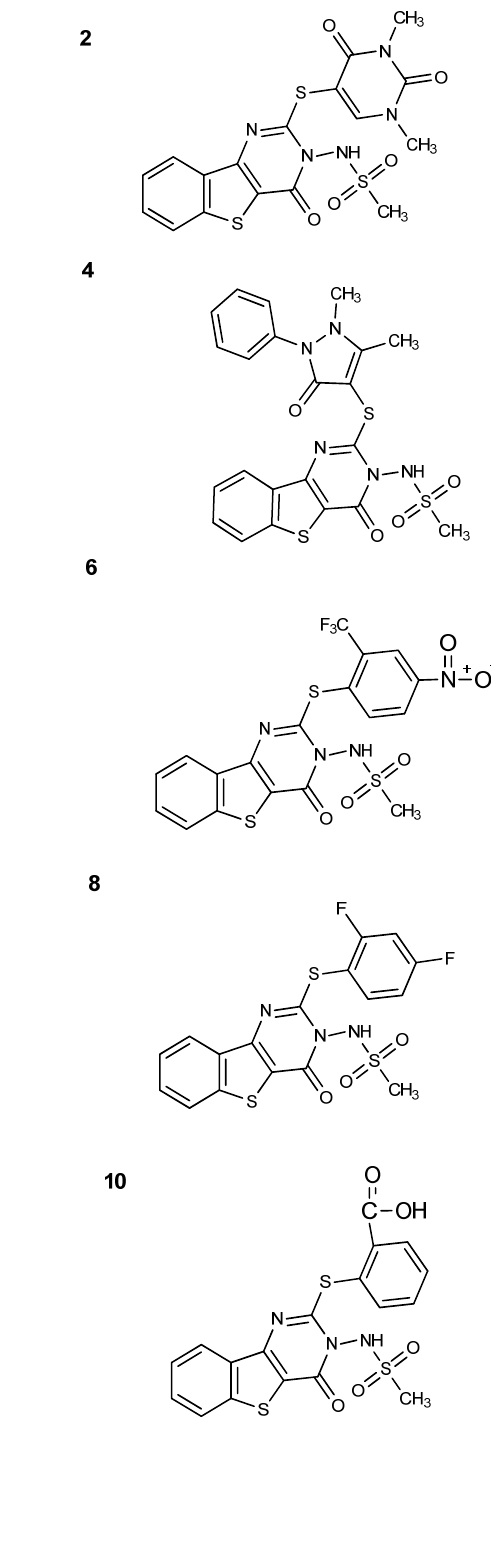
Figure 1. Benzo-thieno[3,2-d] pyrimidine derivatives 1 – 11